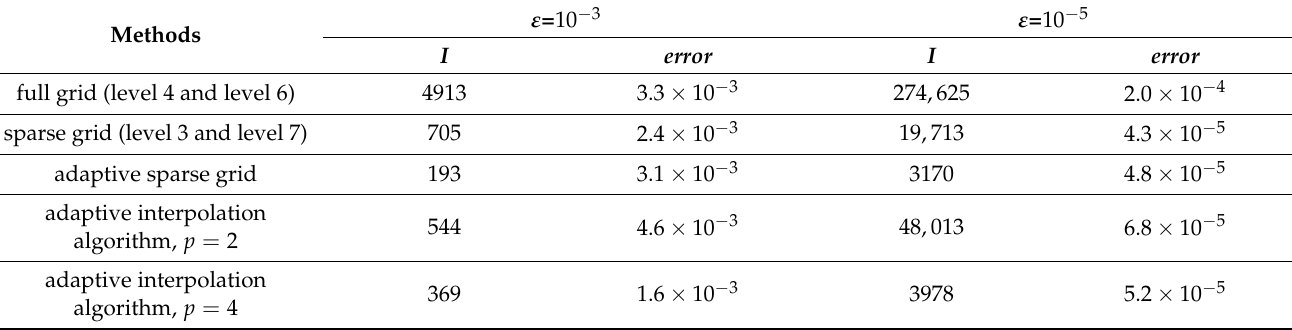
Table 2. Comparison of approaches on system given by Equation